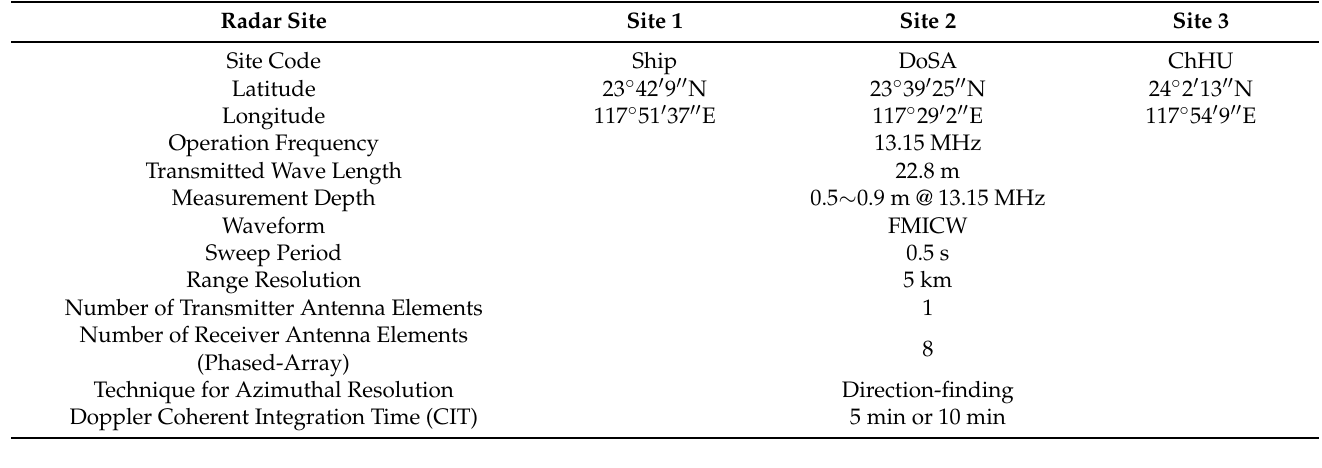
Table 1. Ocean state monitoring and analyzing radar (OSMAR) parameters